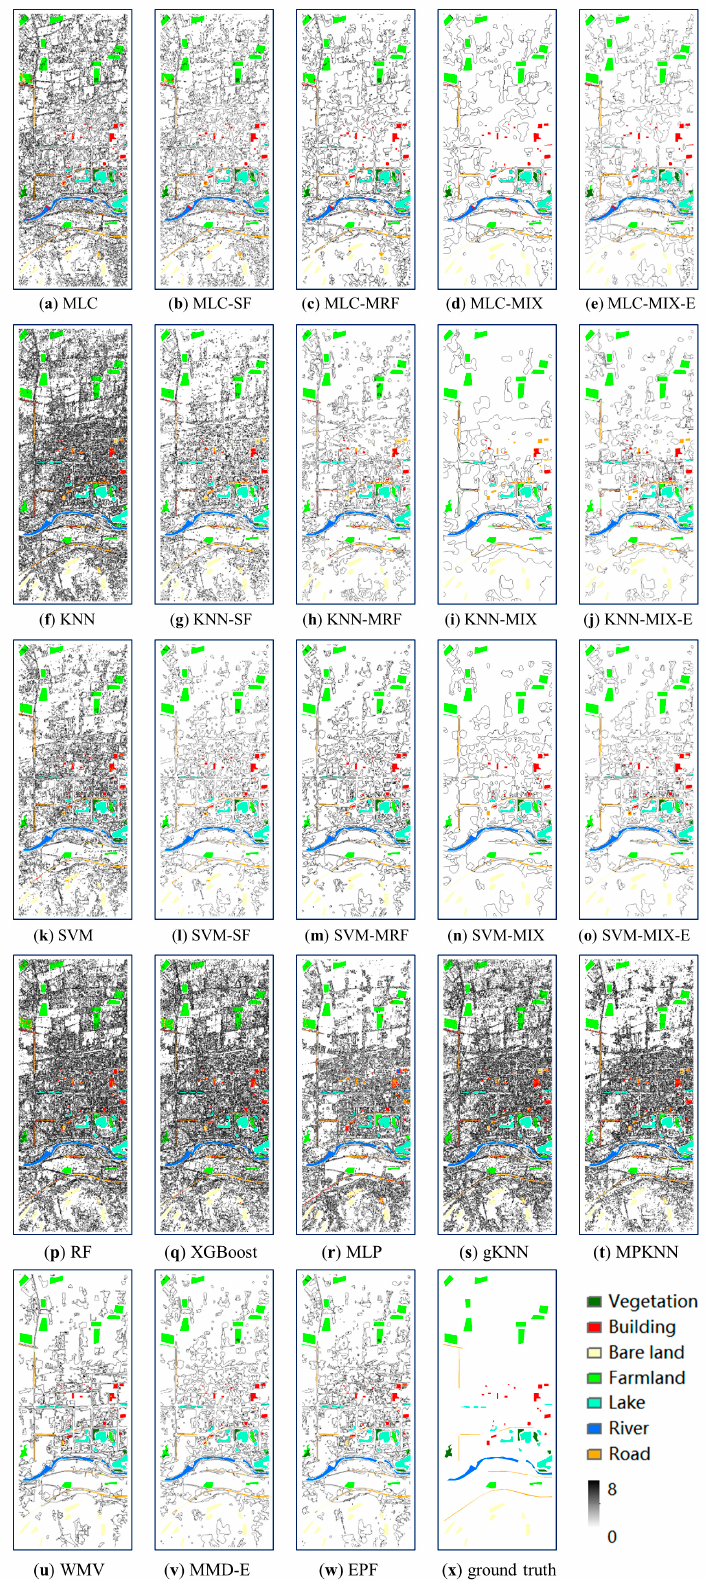
Figure 6. Classification results using different methods for the Landsat image: ( a ) MLC, ( b ) MLC-SF, ( c ) MLC-MRF, ( d ) MLC-MIX, ( e ) MLC-MIX-E, ( f ) KNN, ( g ) KNN-SF, ( h ) KNN-MRF, ( i ) KNN-MIX, ( j ) MLC-MIX-E, ( k ) SVM, (l) SVM-SF, ( m ) SVM-MRF, ( n ) SVM-MIX, ( o ) SVM-MIX-E, ( p ) RF, ( q ) XGBoost, ( r ) MLP, ( s ) gKNN, ( t ) MPKNN, ( u ) WMV, ( v ) MMD-E, ( w ) EPF, and ( x ) ground-truth.